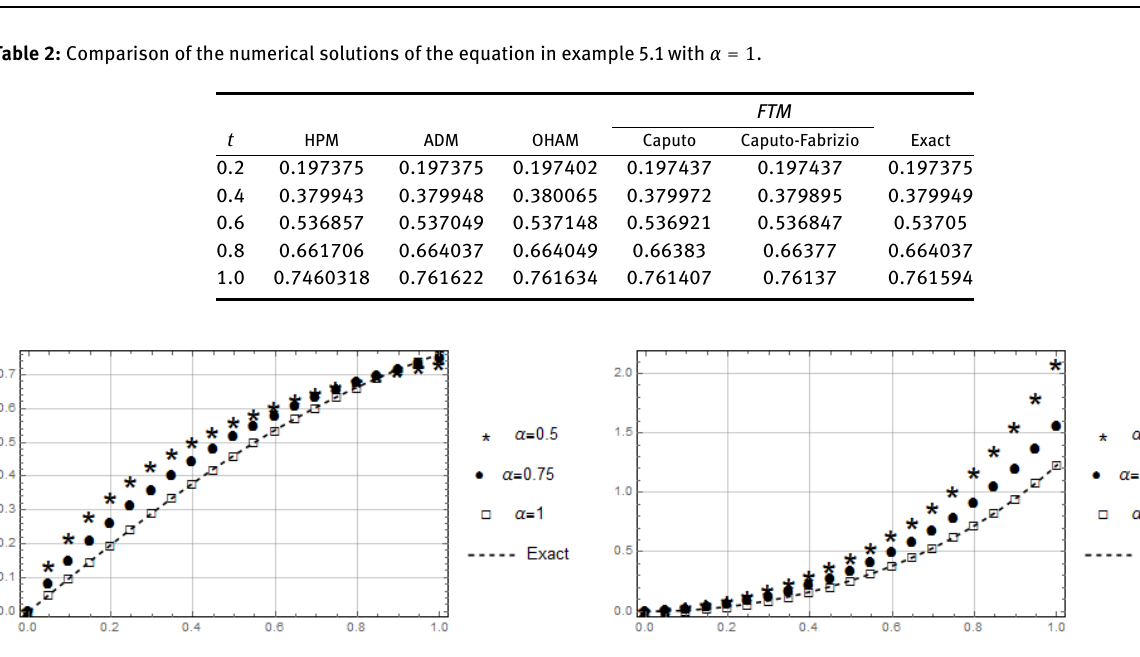
Fig. 3: Comparison betwixt the exact and the approximation solu- tion with F -transform of test example 5.2 for different values of α , n = 500 , τ = 0.002 and various values of t , with Caputo fractional derivative.